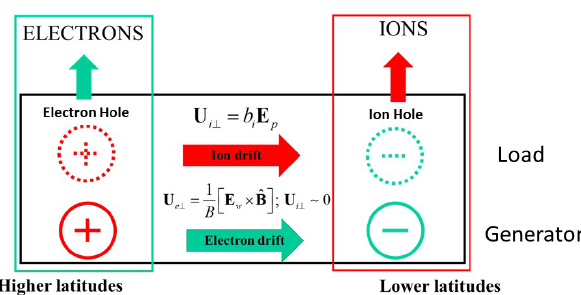
Figure 1. A schematic illustration of the plasma injection arising out of the dynamic ionosphere (ionospheric injection). See the text for a detailed explanation.